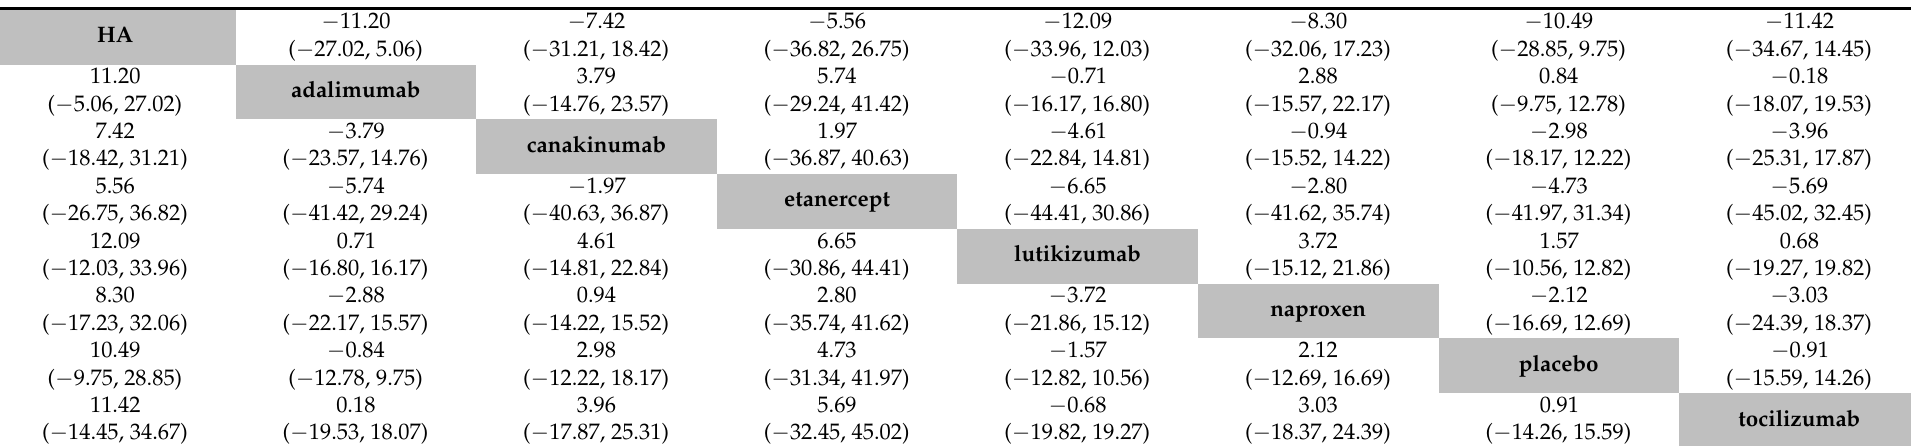
Table 3. Network meta-analysis of physical function for different